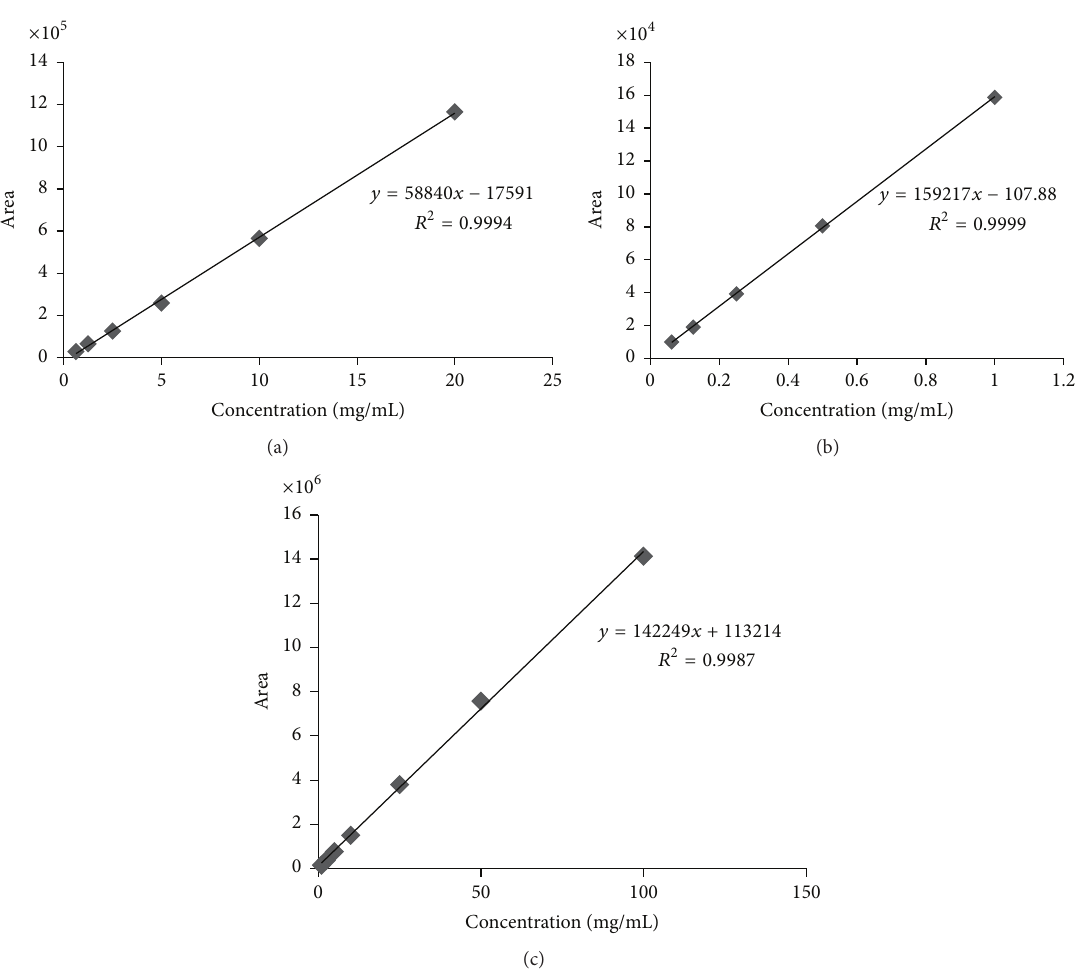
Figure 2: (a) Linearity of lactose by HPLC-RID for both samples. (b) Linearity of lactulose by HPLC-RID for UHT milk samples. (c) Linearity of lactulose by HPLC-RID for condensed milk.